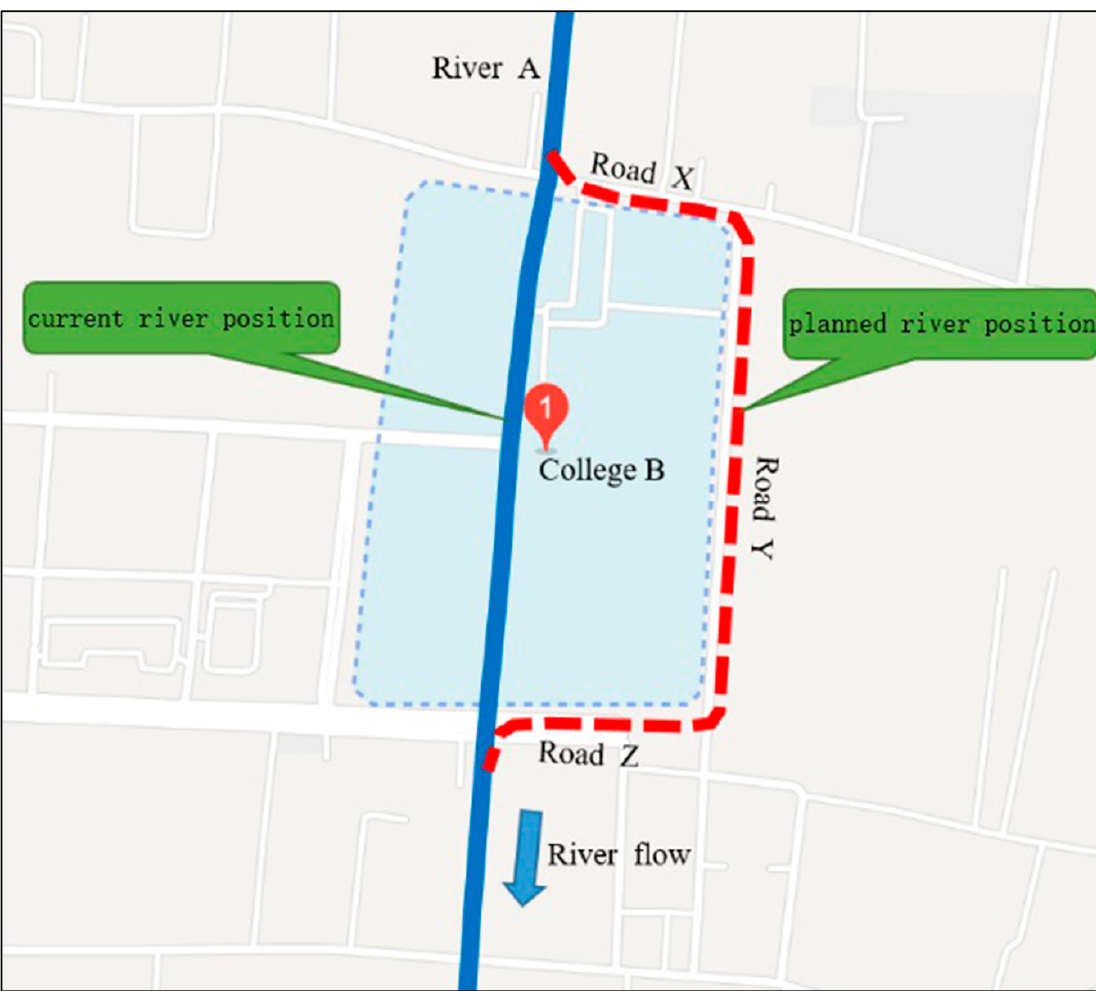
Figure 1. River position schematic diagram.